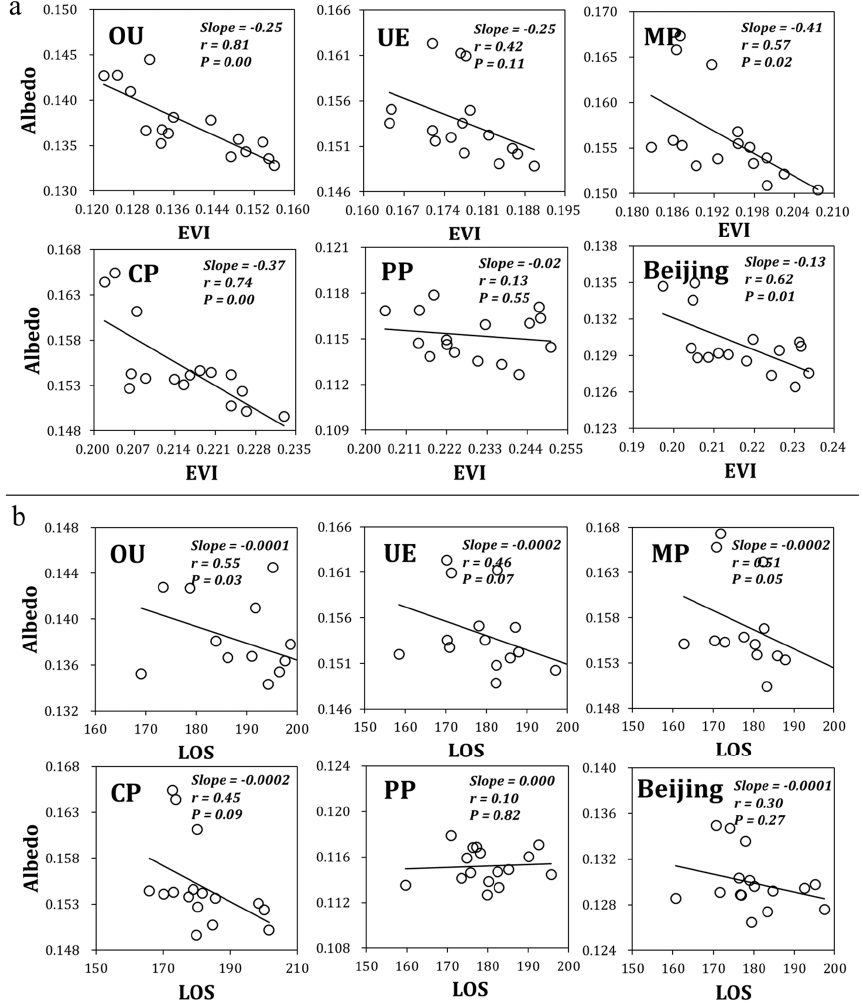
Figure 9. Relationships between the albedo and enhanced vegetation index (EVI), and the length of season (LOS). a is the relationship between albedo and EVI; b is the relationship between the albedo and LOS.